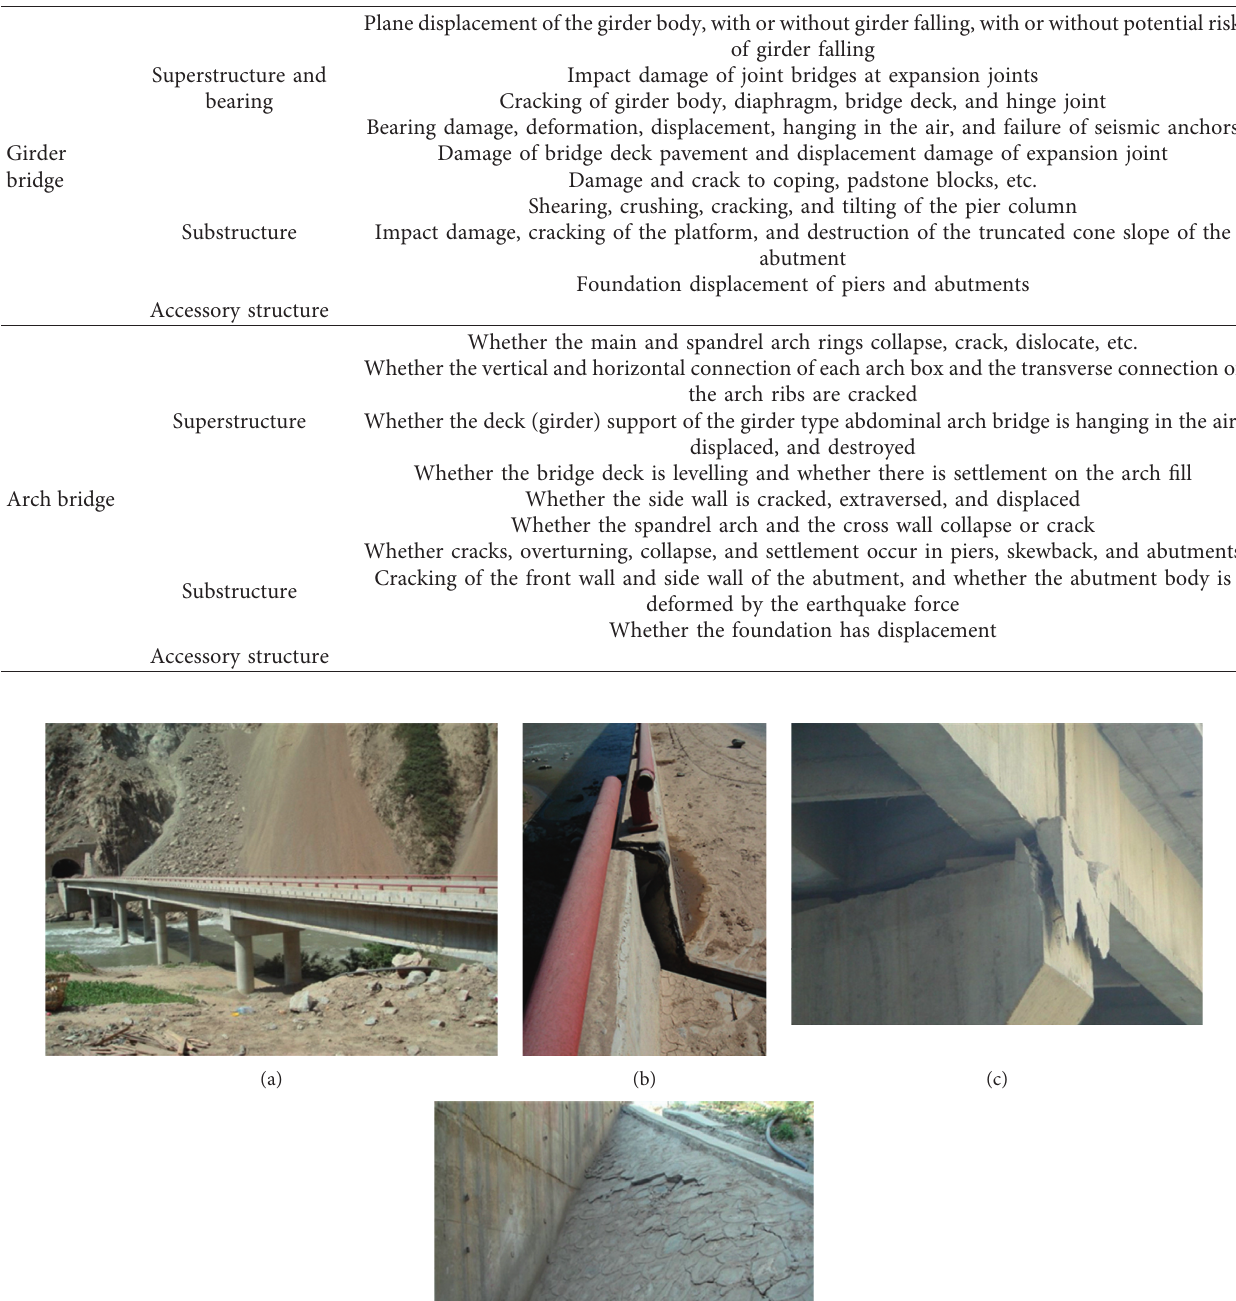
Table 1: Investigation of main seismic damage to the girder bridges and arch bridges.